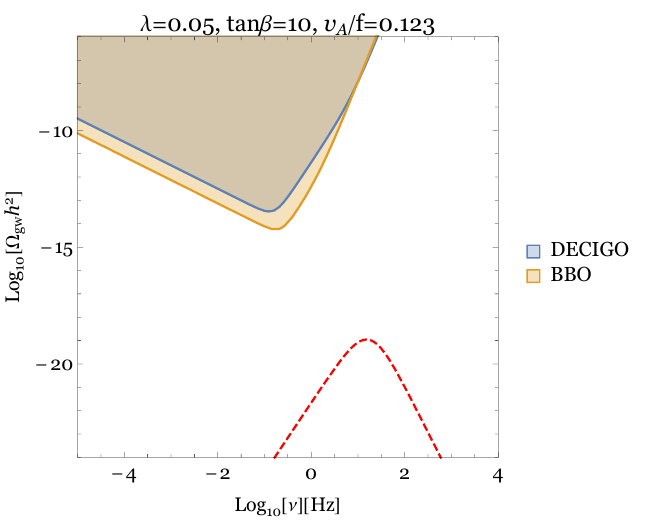
Figure 5 . The gravitational wave amplitude is shown. Orange and blue regions show the detectable regions by BBO and DECIGO,